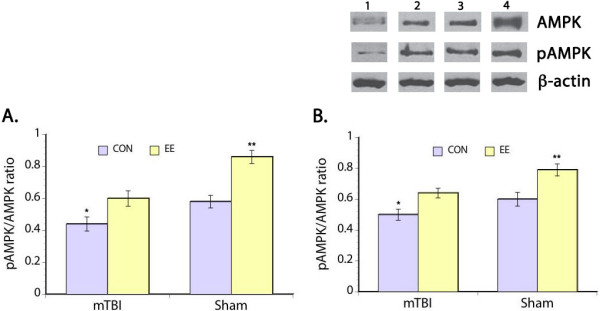
Ratio of pAMPK/AMPK. Representative Western blots of total AMPK and phosphorylated AMPK (pAMPK) in the hippocampus (upper panel). Bar graphs show that the ratio of pAMPK/AMPK is significantly decreased in the prefrontal cortex (A) and hippocampus (B) of mTBI rats assigned to control housing. Housing rats in EE after mTBI restored ratio of pAMPK/AMPK to normal levels. Notably, an overall increase in pAMPK/AMPK is evident in the sham animals housed in EE. *p < 0.05, **p < 0.01. Legend: 1 – mTBI control housing, 2 – mTBI EE housing, 3 – sham control housing, and 4 – sham EE housing.